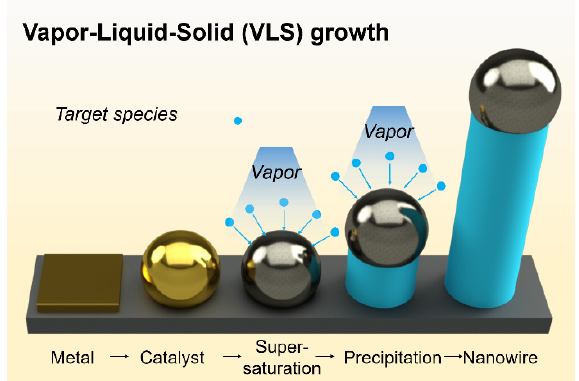
Figure 2. A typical vapor–liquid–solid (VLS) growth mechanism in metal–oxide nanowire fabrica- tion